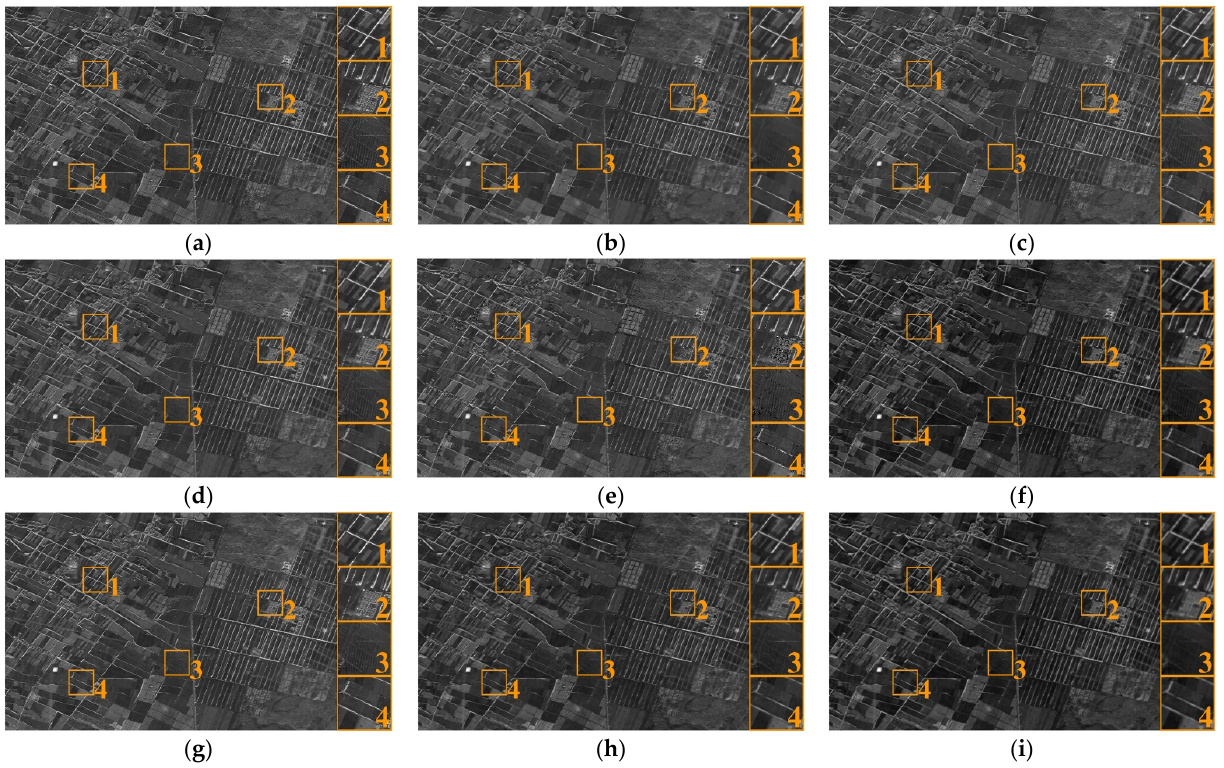
Figure 19. Experimental results on the S-band SAR image: ( a ) is the original image, and ( b – i ) are filtered results of our method, Lee filter, traditional Frost filter, SRAD, NLM, RGF, EDS, and SAR- IRGF, respectively.